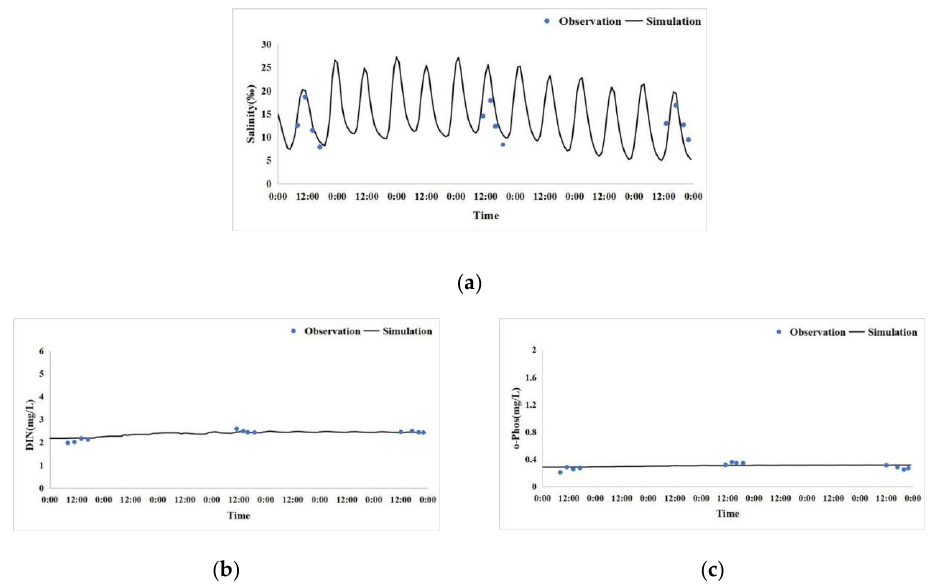
Figure 5. Transmission (TM) model calibration: comparison between model simulated and measured values of each index in Haimen station. ( a ) Salinity; ( b ) DIN; ( c ) ο-phosphate.